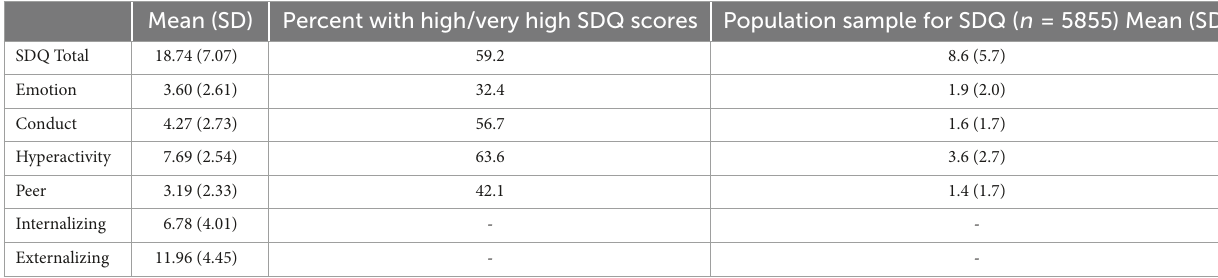
TABLE 6 Means (SD) of SDQ scores and percentage of sample with highly elevated scores ( N =